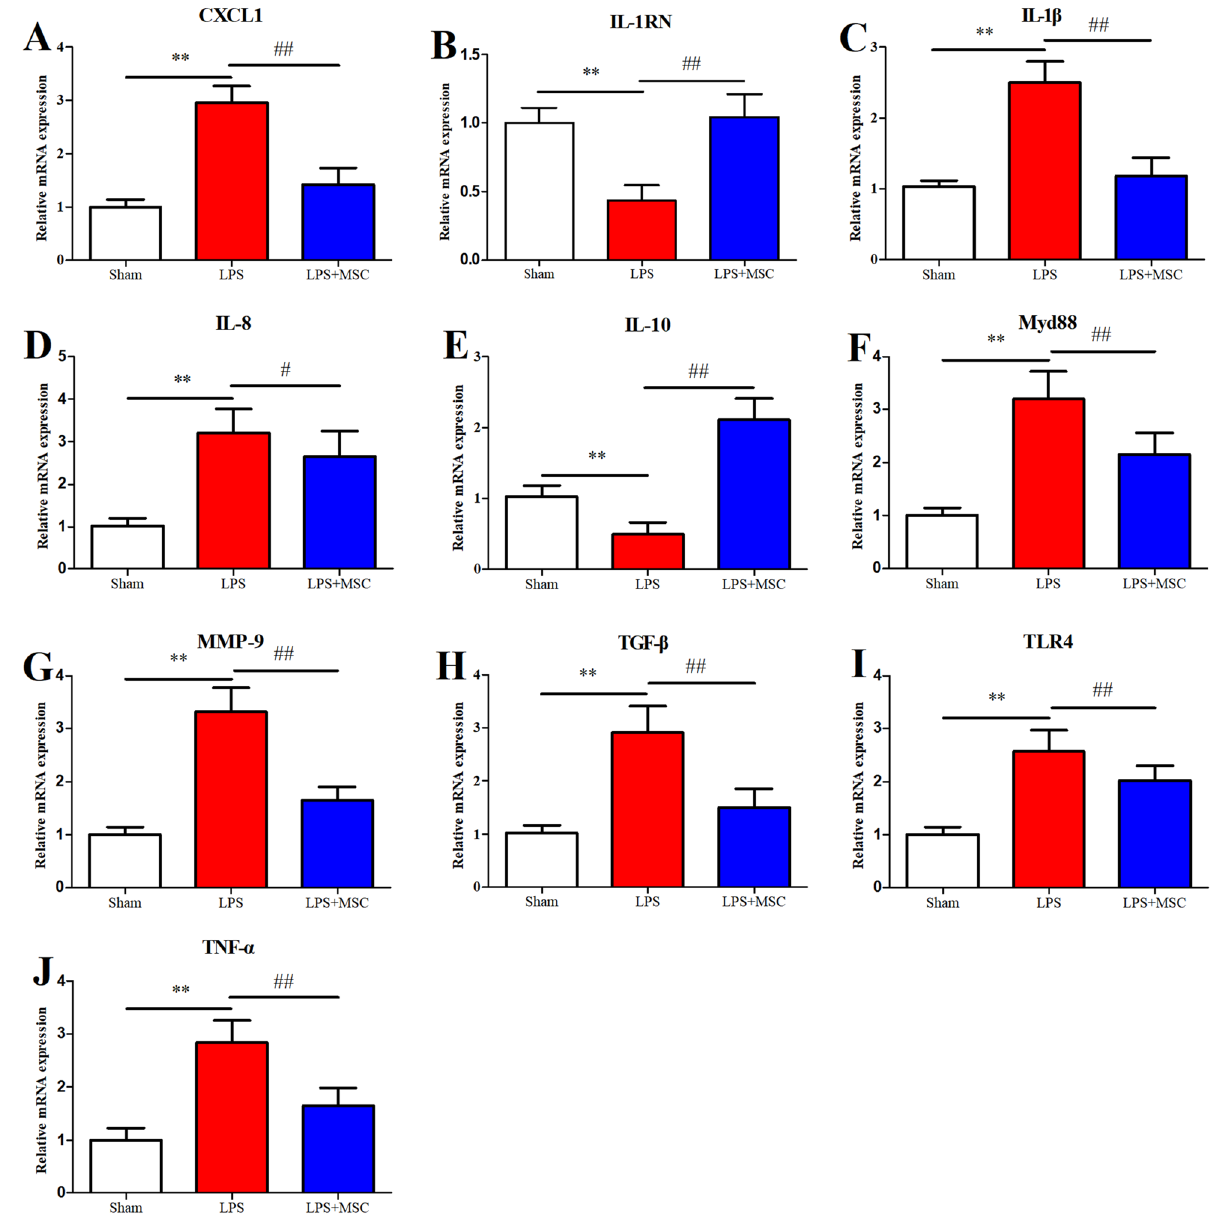
Figure 6. BM-MSCs prevented lung injury via the TLR4/Mdy88 pathway 6 h after LPS treatment. The gene expression levels of CXCL-1 ( A ), IL-1RN ( B ), IL-1β ( C ), IL-8 ( D ), IL-10 ( E ), Mdy88 ( F ), MMP-9 ( G ), TGF-β ( H ), TLR4 ( I ), and TNF-α ( J ) were detected. * P < 0.05 compared with the Sham group. * P < 0.05 versus the Sham group; # P < 0.05 versus the LPS group; ** P < 0.01 versus the Sham group; ## P < 0.01 versus the LPS group. Values are expressed as the mean ±